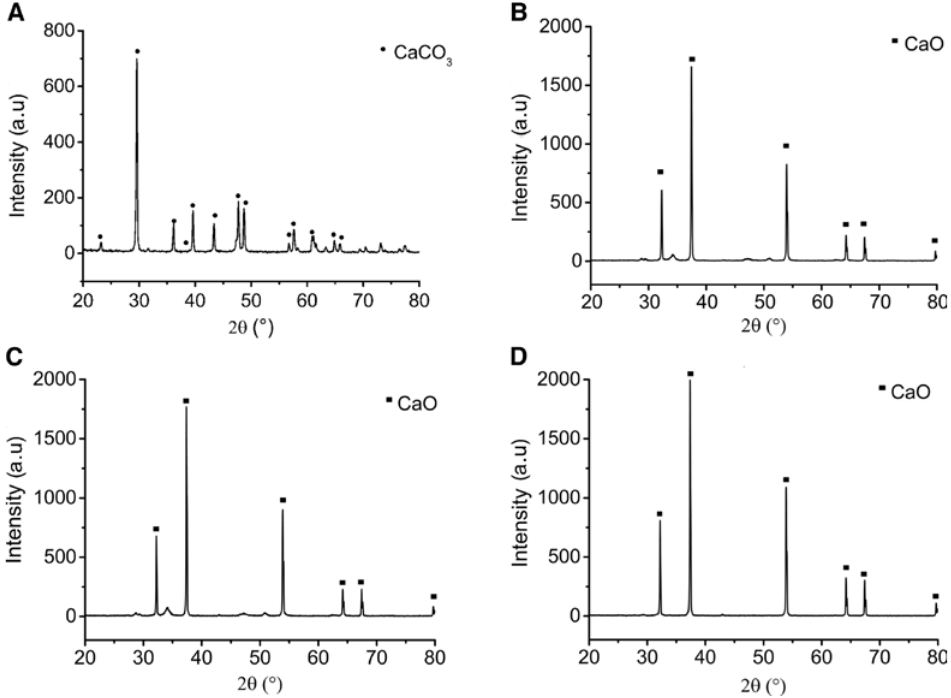
Figure 1: X-ray diffractogram of (A) in natura eggshell, (B) eggshell calcined at 800 ° C, (C) eggshell calcined at 900 ° C and (D) eggshell calcined at 1000 °